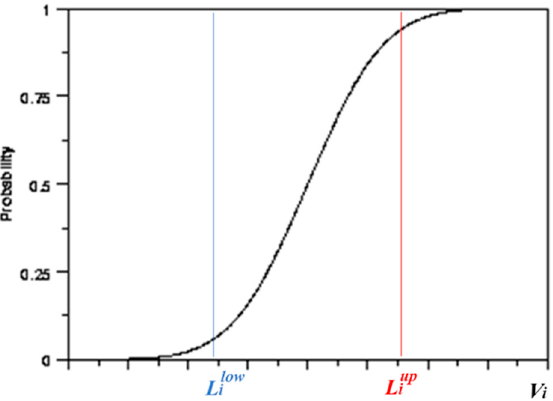
Figure 2. Representation of the accumulative distribution function for the voltage in a non-specific bus i .